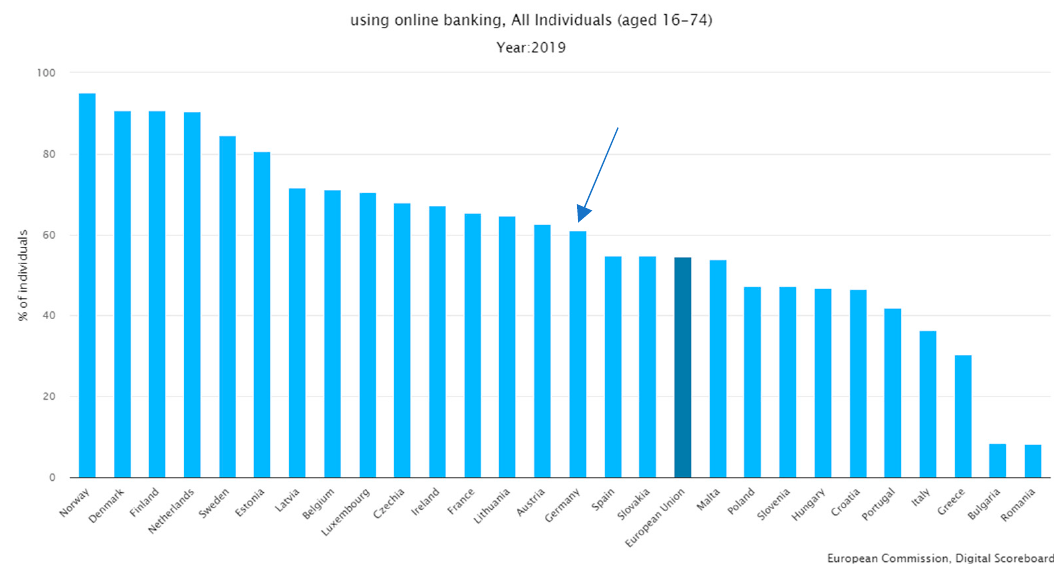
Figure 1. German use of online banking